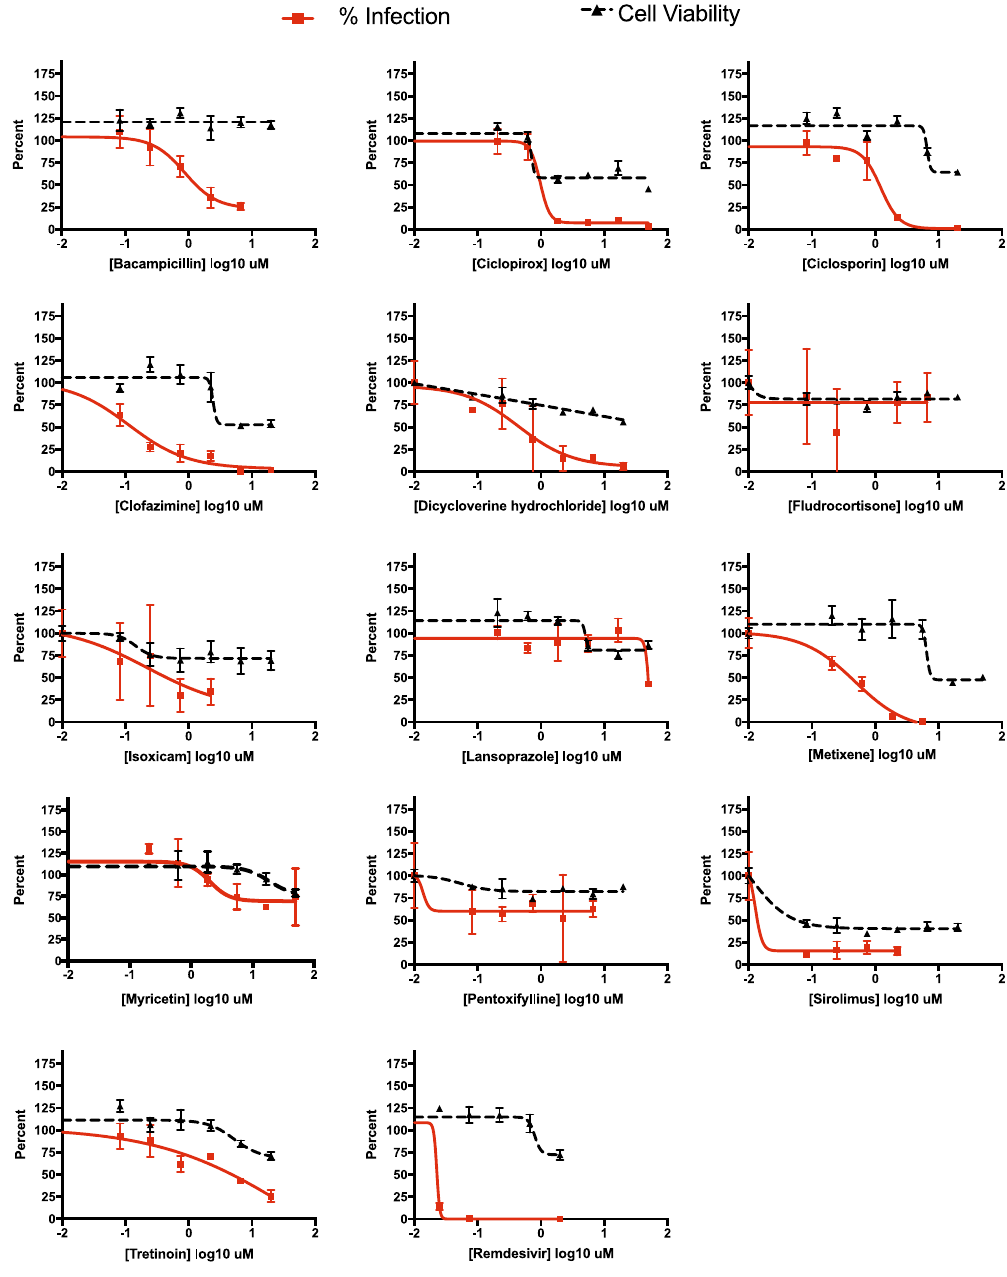
Figure 5. Viral inhibition and cell viability tests of 13 compounds in 293T-ACE2 cell assays. Several drugs inhibit viral infectivity. Red, viral infectivity (anti-NP); black, cell viability. The lack of a dose response in cell viability probably reflects cytostatic and not cytotoxic effects. Data are mean ± sd; n = 3 biologically independent samples for cell viability data. Cells were incubated for 24 h at 37 °C in 5% CO 2 . Then, 2 h before infection, the medium was replaced with 100 μl of DMEM (2% FBS) containing the compound of interest at concentrations 50% greater than those indicated, including a DMSO control. 100 PFU (MOI = 0.025) was added in 50 μl of DMEM (2% FBS), bringing the final compound concentration to those indicated. Plates were then incubated for 48 h at 37 °C. The cells were then immunostained for the viral NP